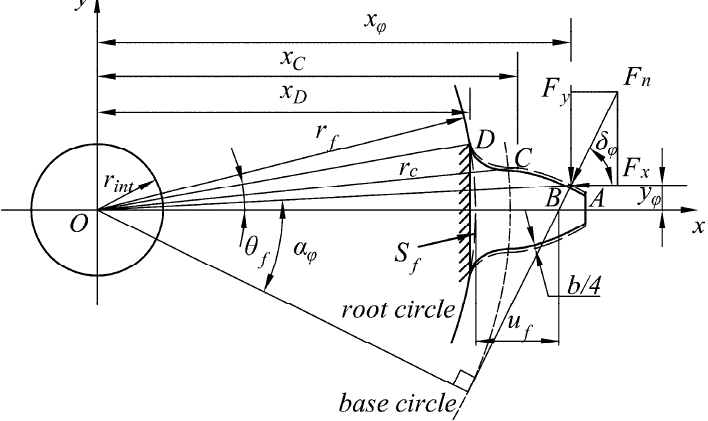
Figure 2. The geometric model of the gear profile.